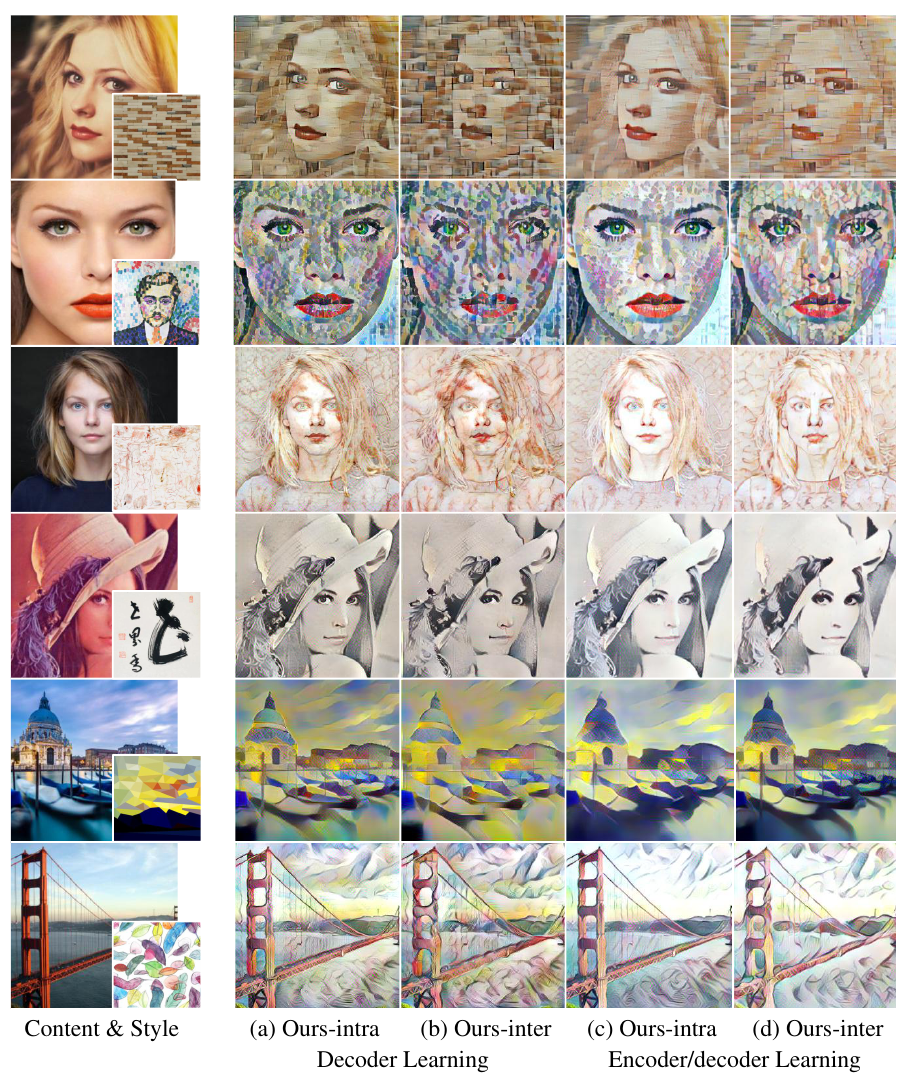
Figure 13. The result of the proposed method learning the networks with the end-to-end learning scheme and the proposed method learning the decoder network only: each target content image and style image were not used during network